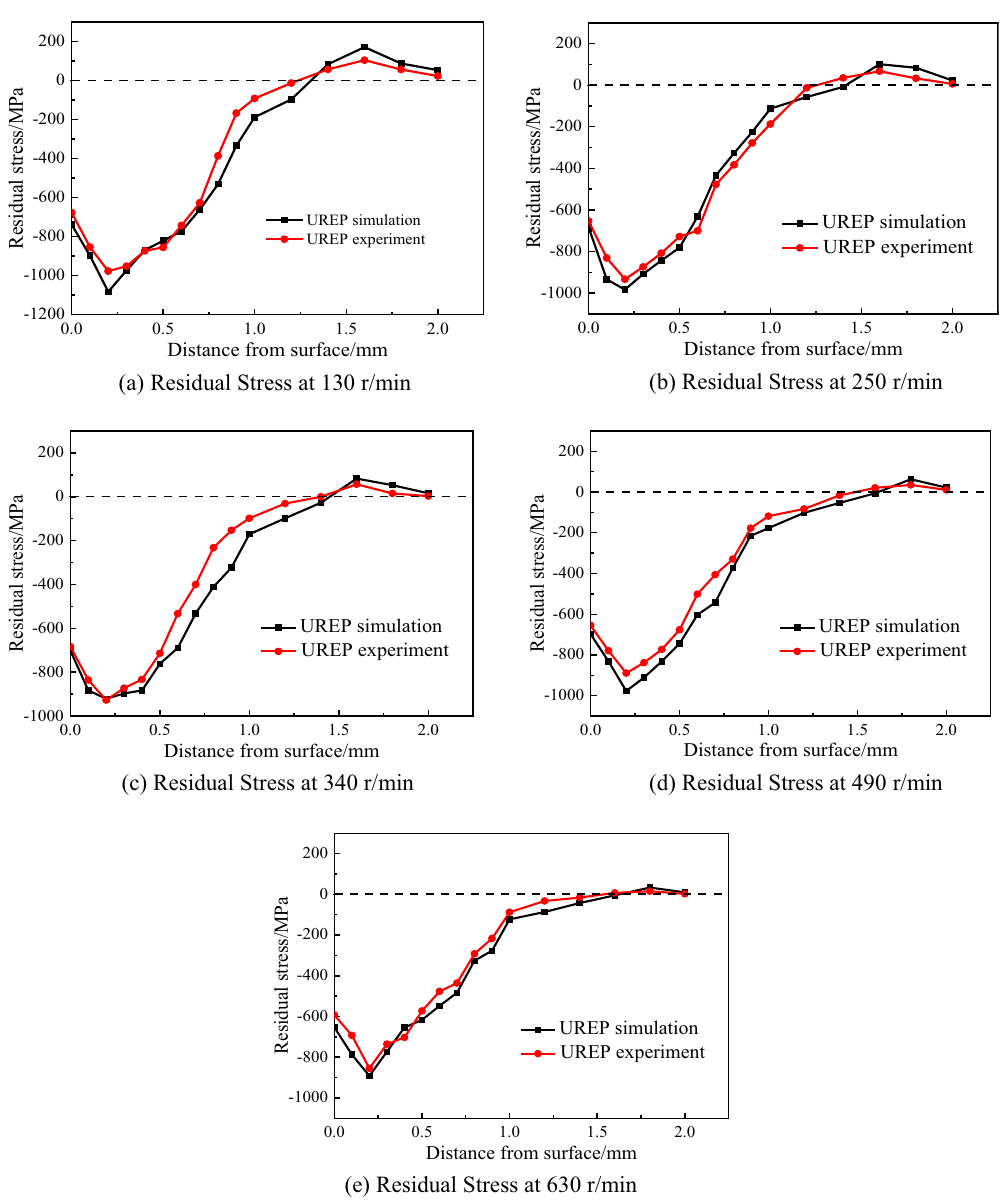
Figure 6. Residual stress of UREP at different rotational